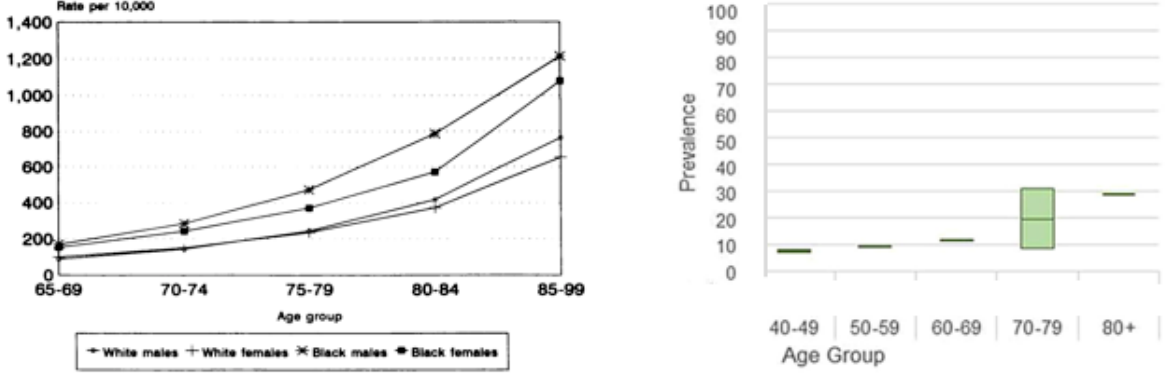
Figure 3. ( Left ) Rate of hospitalisation with any listed diagnosis of dehydration per 10,000 elderly Medicare beneficiaries, 1991. Reprinted with permission from ref. [5]. Copyright 2021 American Public Health Association. ( Right ). Prevalence of clinically diagnosed dry eye by age. Adapted with permission from ref. [152]. Copyright 2017 Elsevier Inc.